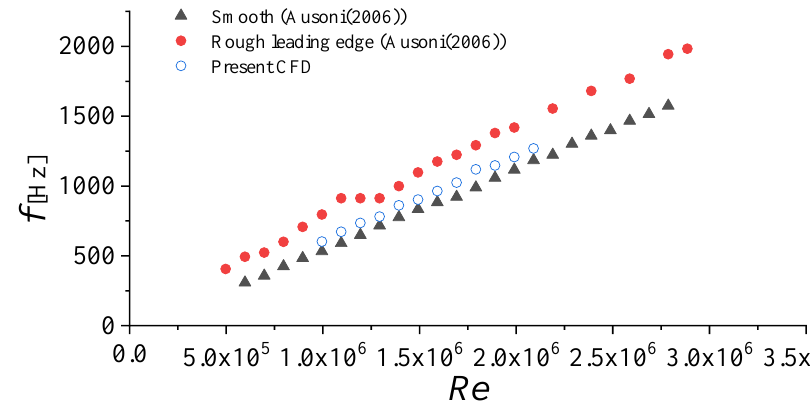
Figure 11. Oscillation frequency with different inflow velocities.